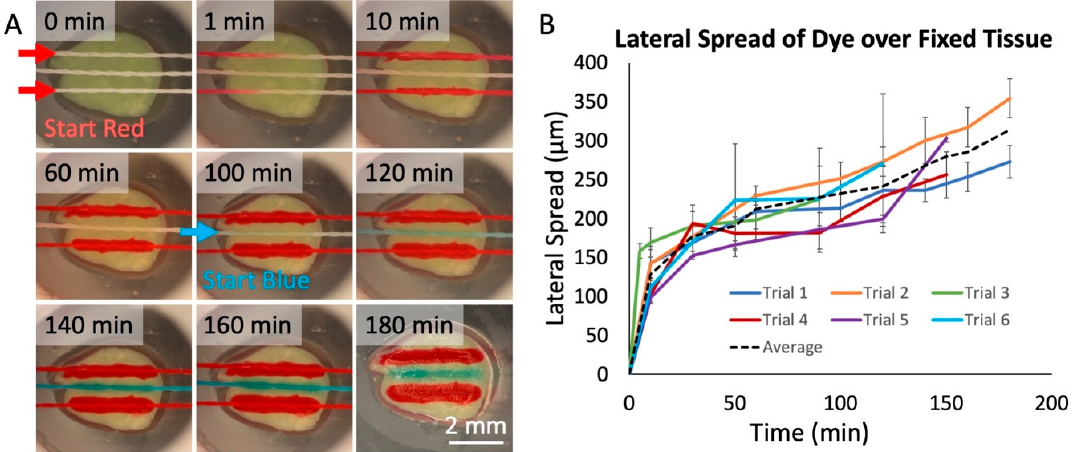
Figure 4. Dye delivery to fixed tissue. ( A ) Red and blue food-coloring dye delivered onto fixed glioblastoma tissue over a 3-hr period in a humidified chamber at room temperature. The two lateral threads flowed red dye. The center thread initially flowed phosphate buffered saline (PBS) buffer, replaced by blue dye at 100 min. After 180 min, the tissue was photographed without the device. ( B ) Measured lateral spread of red dye on fixed tissue over time for six threads in two/three separate device runs. Each measured point was then calculated by taking the average and standard deviation of 10 separate spread measurements at each time, with spread estimated as the total lateral width/2. The black dashed line represents the average of all trials.